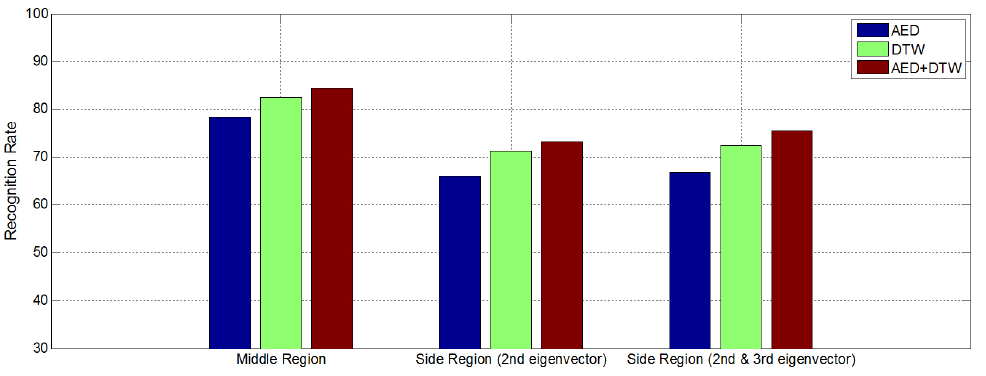
Figure 20. Recognition rate in terms of region of